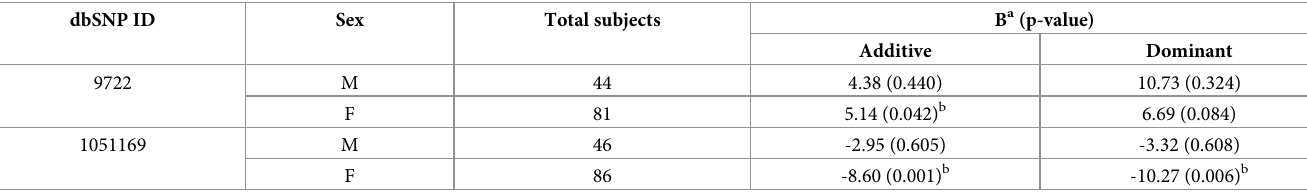
Table 6. Sex specific single SNP regression analysis of